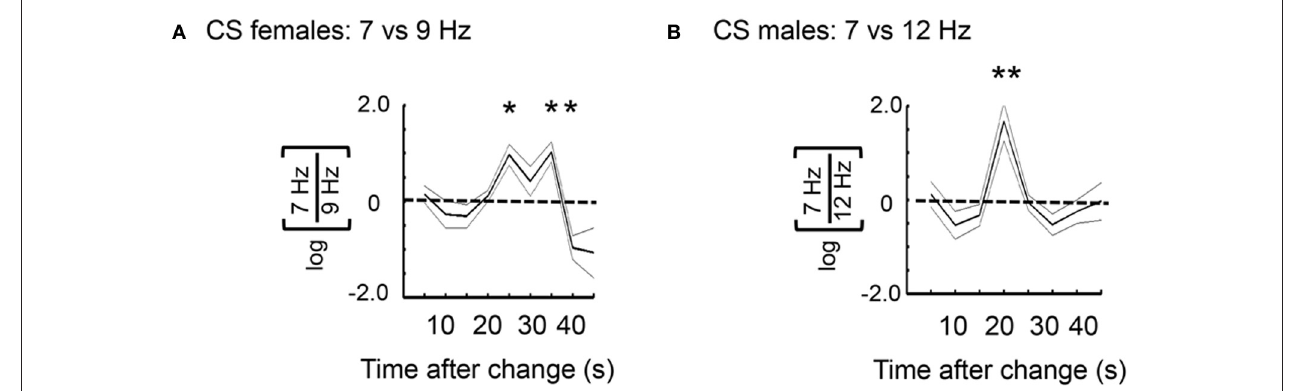
∗ P < 0 . 05, by t -test compared to 0, dashed line). (B) Log-ratio for 7Hz vs. 12Hz surround, for 40s after novelty ( n = 5 male flies, ∗ P < 0 . 01, by t -test compared to 0, dashed